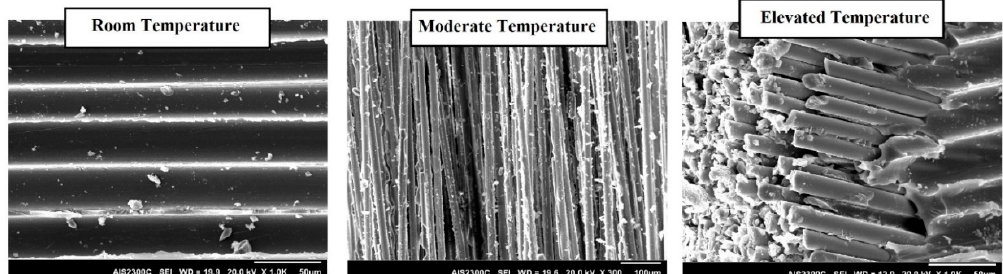
Figure 4. SEM images of FRP laminates after exposure to elevated temperatures.